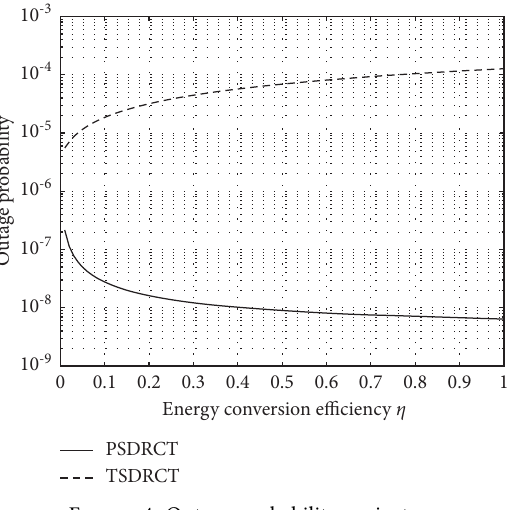
Figure 4: Outage probability against η